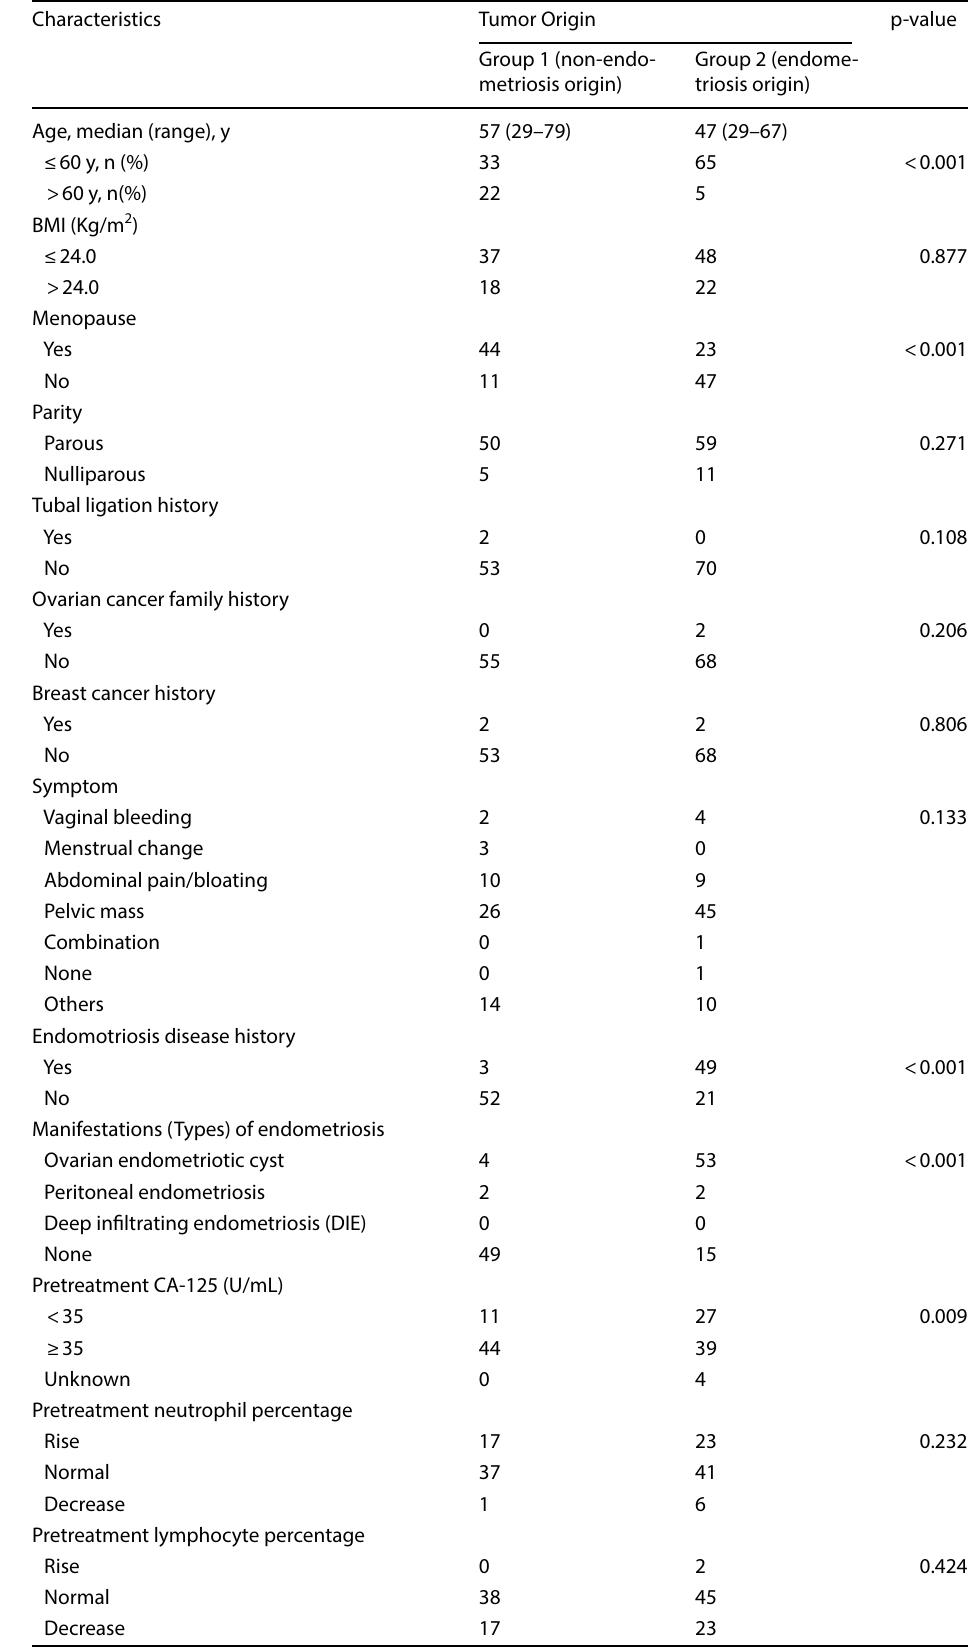
Table 5 Comparison of 125 OCCC with and without endometriosis